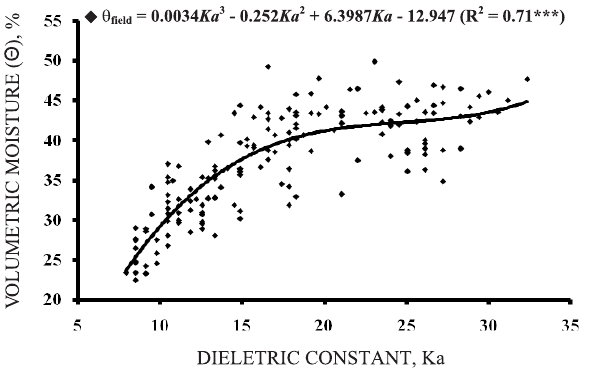
Figure 1. Correlation between apparent dielectric constant of the soil (Ka) measured by Trase System, TDR, with volumetric moisture ( θθθθθ ) in a clayey